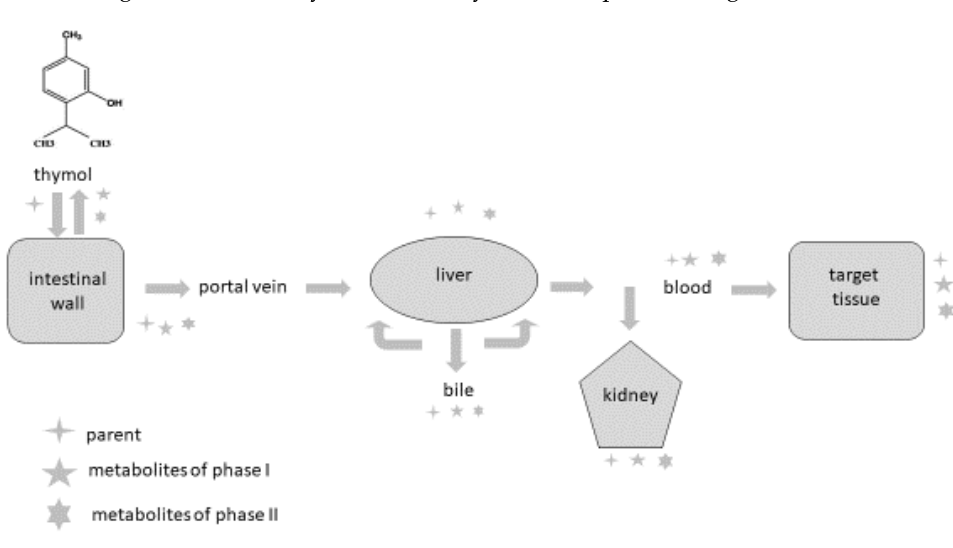
Figure 1. Organ bioavailability barriers to thymol (based on [79]).